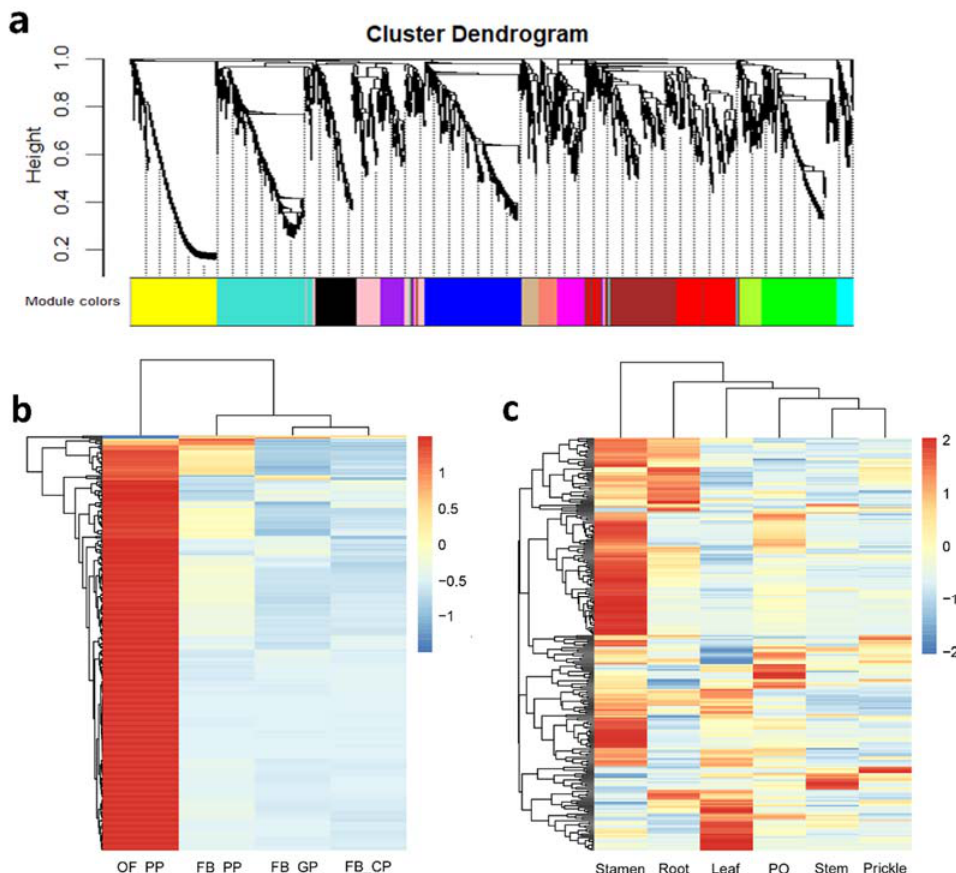
Figure 4. WGCNA of the geraniol biosynthesis-related module. ( a ) Hierarchical cluster tree showing the co-expression modules identified by WGCNA. Each tree leaf represents one gene. ( b ) Heatmap representation of gene expression levels for green-module genes differentially expressed during the following four petal developmental stages of Old Blush: FB_GP, green petals in the flower bud; FB_CP, petals changing colors in the flower bud; FB_PP, pink petals in the flower bud; OF_PP, pink petals on the open flower. ( c ) Heatmap representation of gene expression levels for green-module genes differentially expressed in other tissues of Old Blush plants (stamen, root, leaf, pistil and ovary [PO], stem, and prickle).